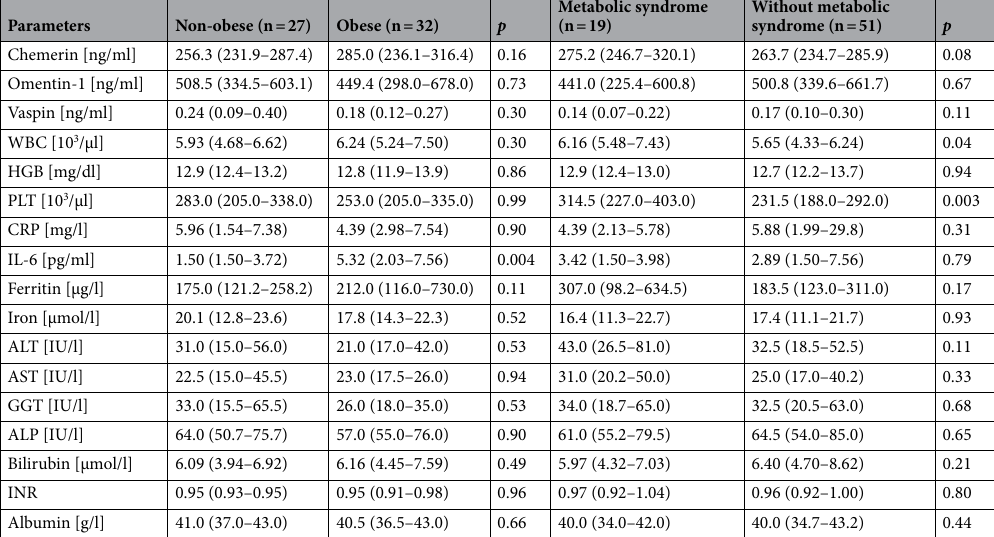
Table 2. Comparison of analyzed parameters between patients with and without obesity as well as with and without metabolic syndrome.